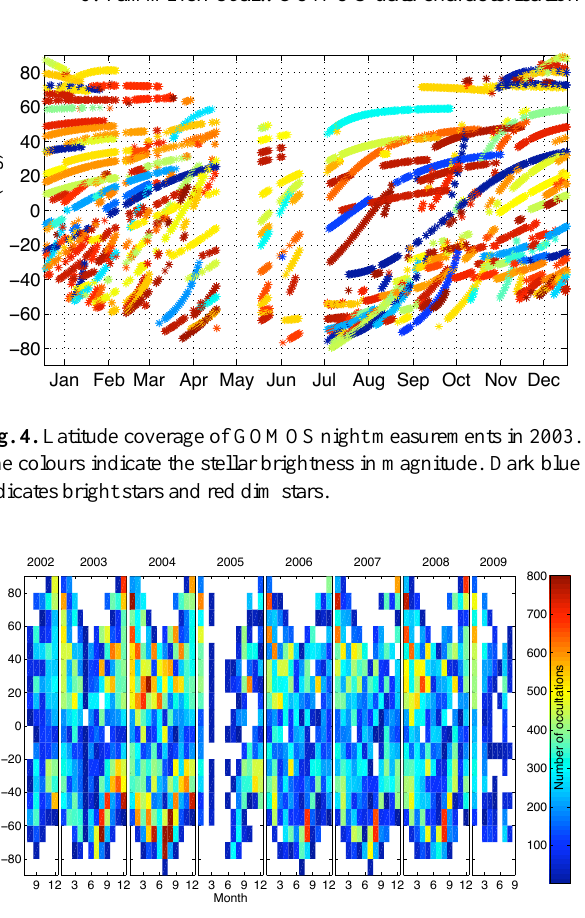
Fig. 5. Latitudinal distribution of GOMOS data availability during summer 2002–autumn 2009. Only night-time data is considered here, i.e., solar zenith angle larger than 107 deg. Colour coding refers to number of available night-time